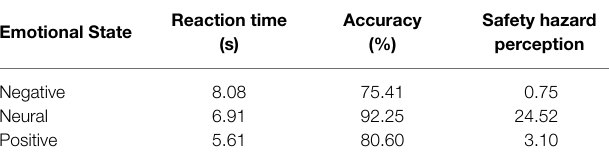
TABLE 7 | Safety hazard cognition results in different emotional states. Emotional State